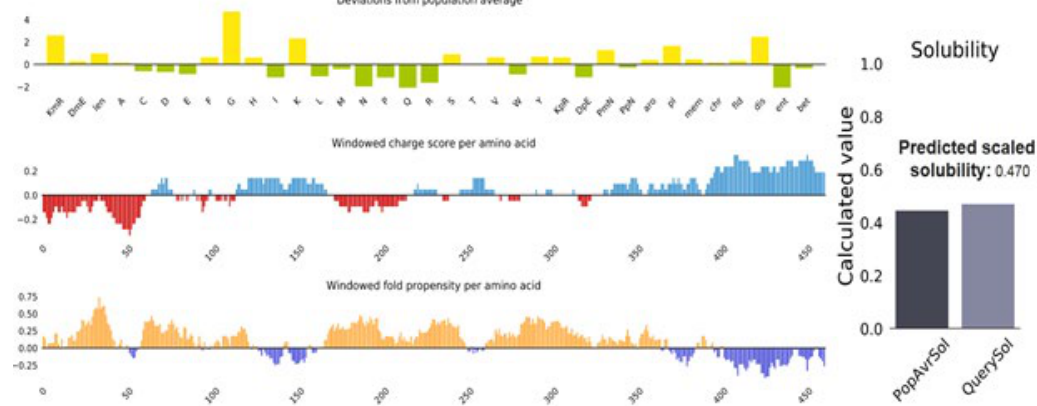
Fig. 6. Vaccine construct solubility as obtained by protein sol server. The solubility of the vaccine construct was shown to be 0.470 compared to 0.45 of the population average solubility of E. coli.